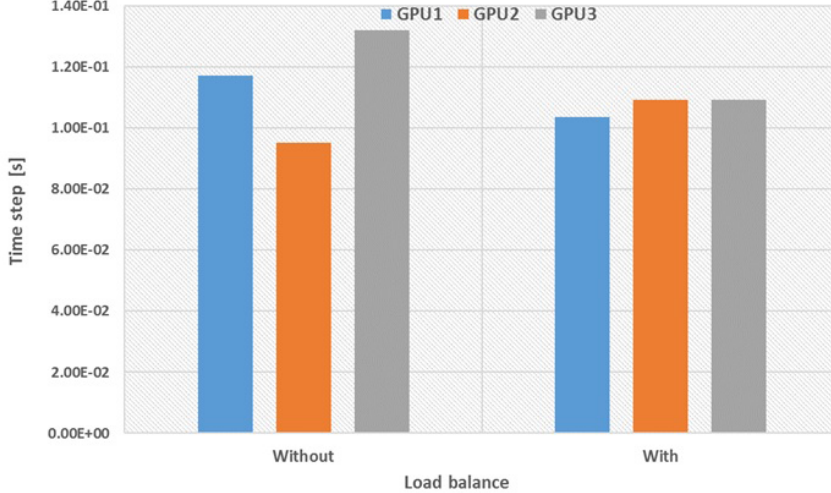
Figure 15. GPU execution time with and without load balance.